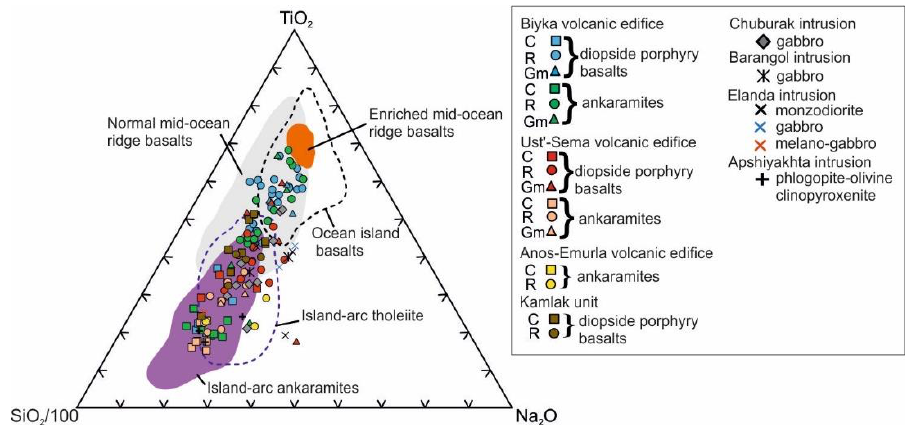
Figure 11. TiO 2 -SiO 2 /100 – Na 2 O (wt.% ) discriminating diagram [13] for clinopyroxene from the Ust’ - Sema Formation and the Barangol Complex rocks. The island arc ankaramites field is according to [33 – 36] and other fields are according to [13].